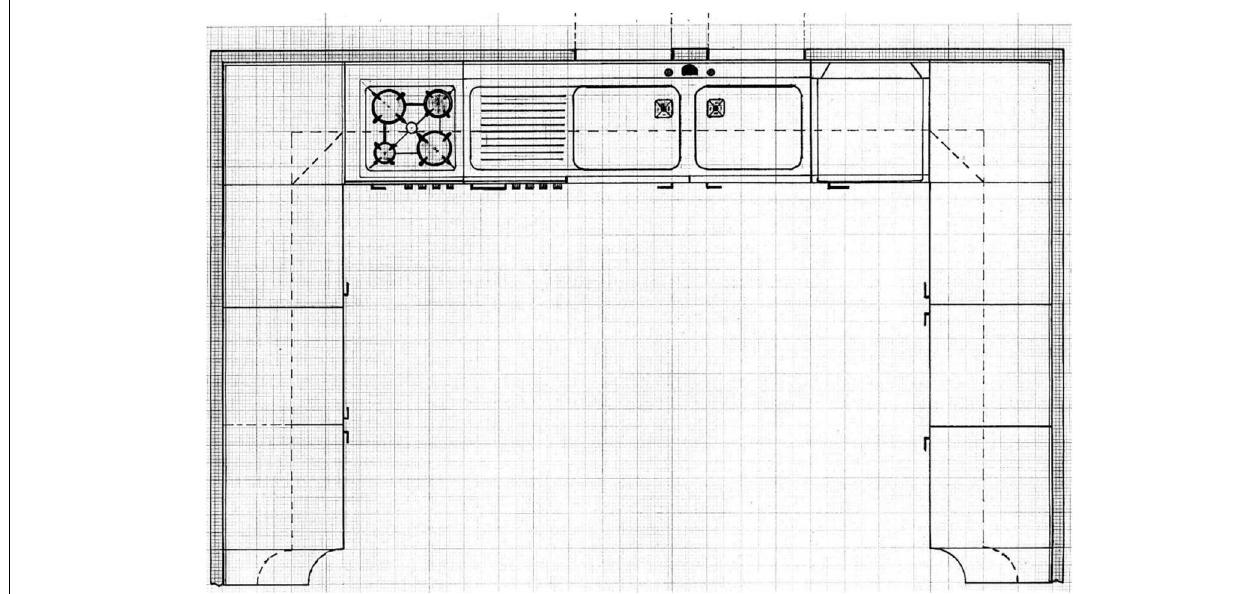
FIGURE 1 | Experimental